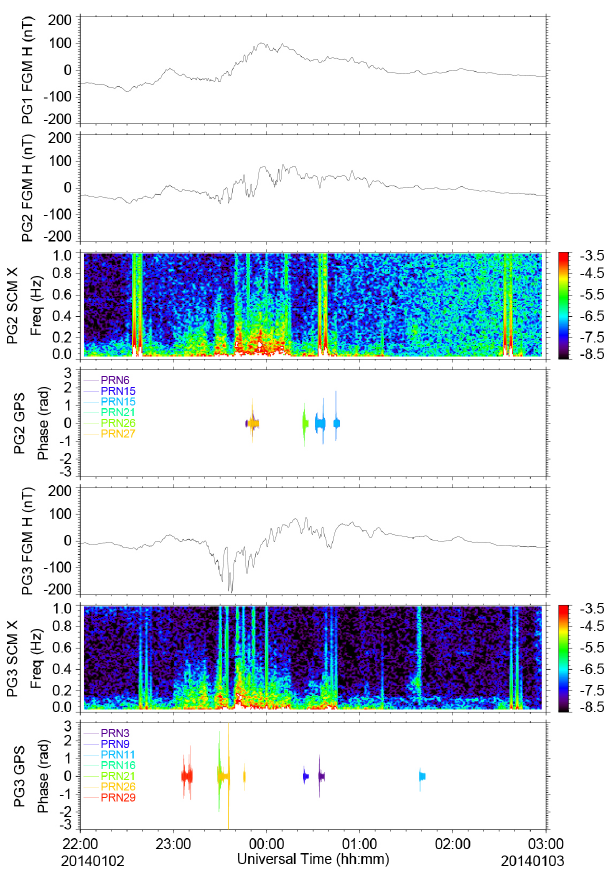
Figure 16. Measurements at the three remote field stations (PG1, PG2 and PG3) from 22:00UT on 2 January 2014 to 03:00UT on 3 January 2014 showing magnetic field disturbances and associated with GPS signal sintillations observed by (a) PG1 fluxgate mag- netometer; (b–d) PG2 fluxgate and induction magnetometers, and GPS scintillation monitor; and (e–g) PG3 fluxgate and induction magnetometers, and GPS scintillations monitor. Note that the mag- netic field data are measured from the H (fluxgate magnetometer) and X (induction magnetometer) components, both of which are aligned along the horizontal local magnetic field